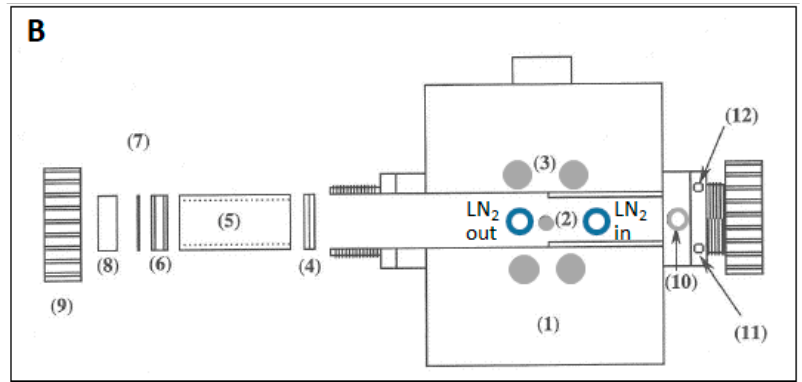
Figure 9. ( A ) Schematic diagram of the vacuum system and infrared (IR) cell used; (A) side view of IR cell, (B) top view, (C) IR beam, (D) gas bulb, (E) liquid bulb, (F) cold trap, (G) pressure gauge, (H) pirani probe head, (I) penning probe head, (J) diffusion pump, (K) roughing pump, and (L) Teflon valves. ( B ) A semi cross-sectional view of the in situ infrared cell. (1) Stainless steel body, (2) thermocouple, (3) cartridge heaters, (4) catalyst sample holder, (5) spacer, (6) CaF 2 windows, (7) Viton